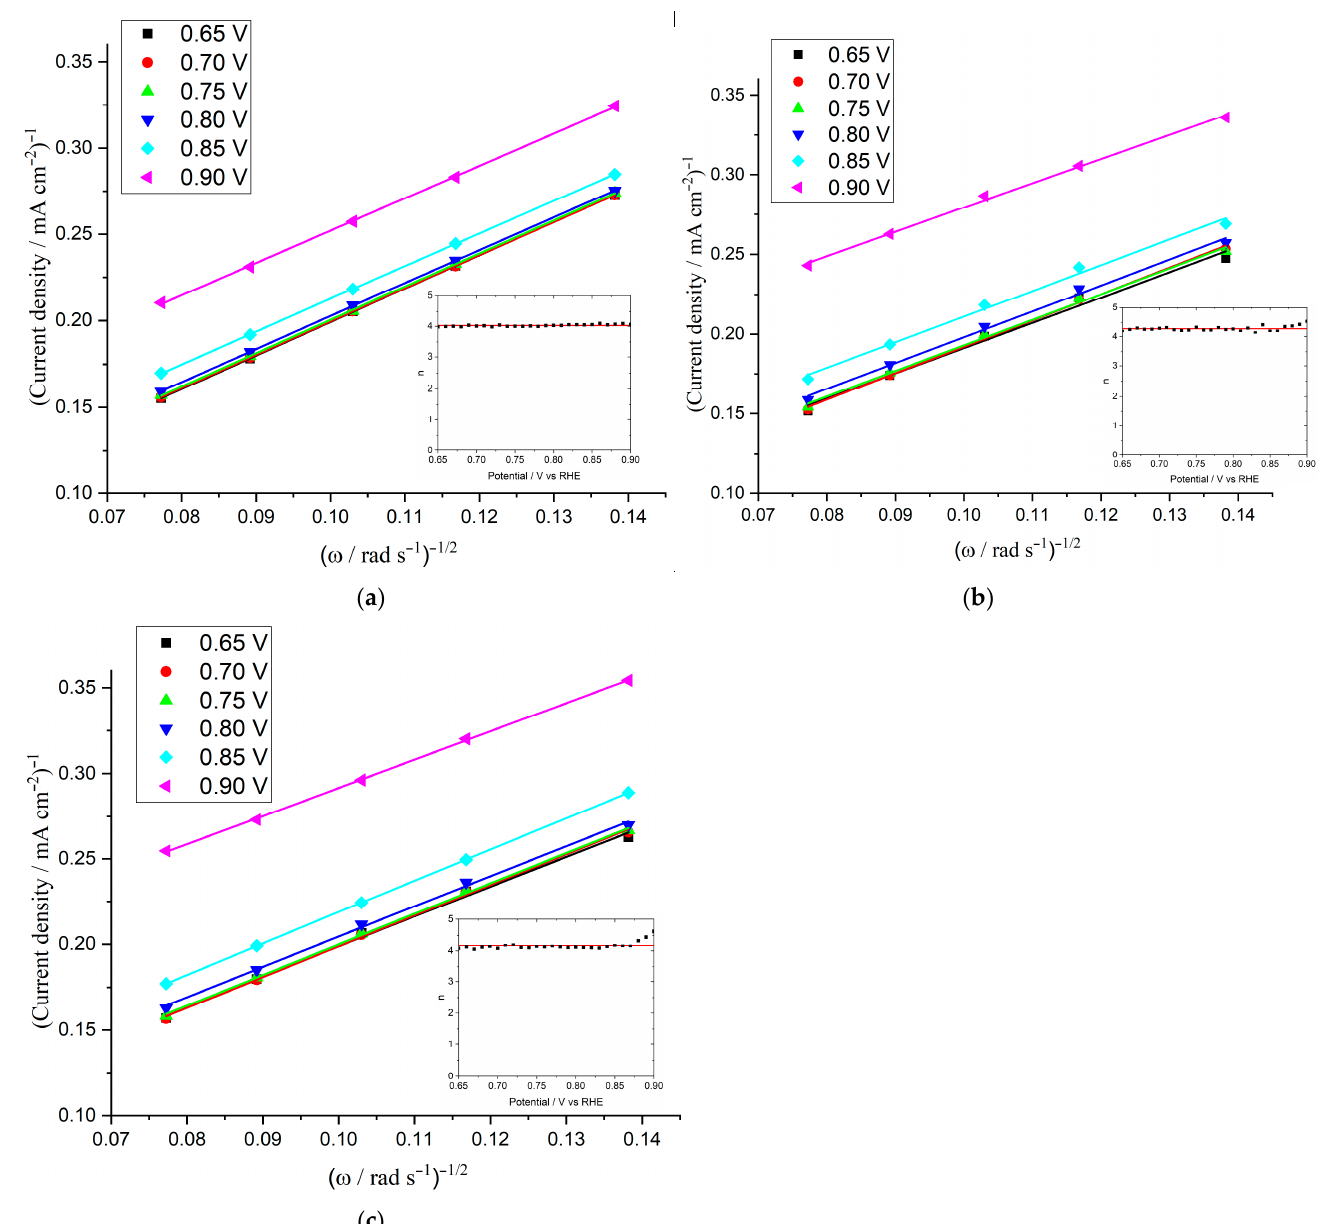
Figure 7. K-L plots calculated from the Pt 20 /C ( a ), Pt 20 SnO 25 /C ( b ), Pt 20 SnO 210 /C ( c ) RDE polarization curves at 50 °C. Inset: n value as a function of the electrode potential.